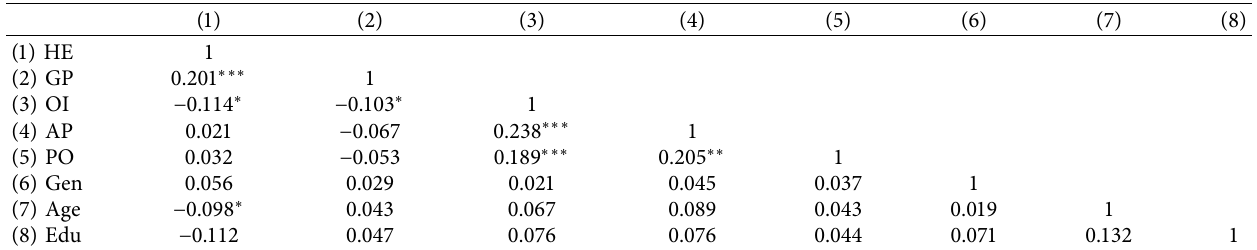
Table 3: Correlation